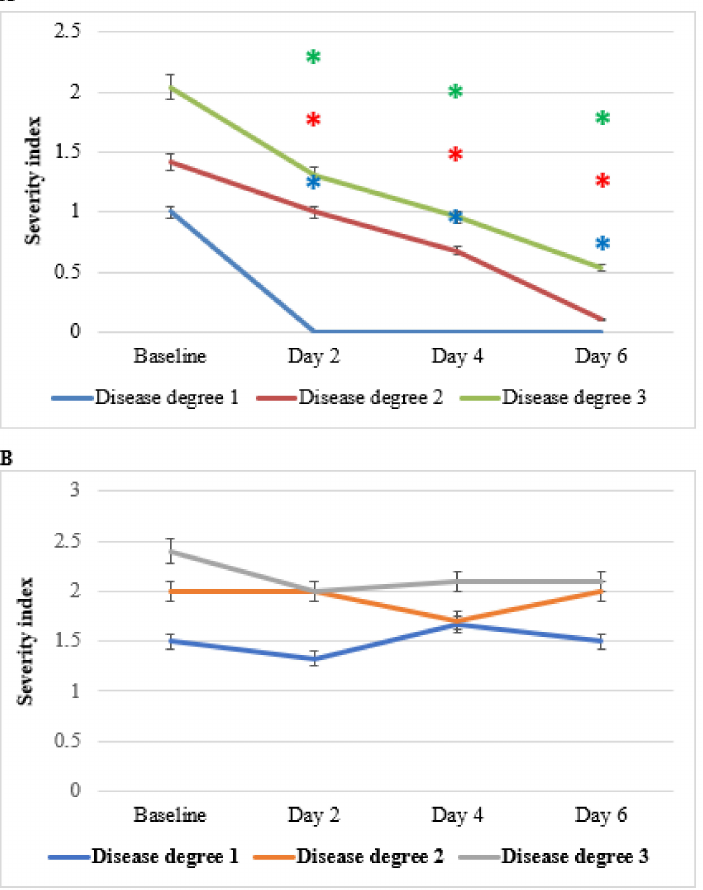
Figure 9. Effect of anti-hemorrhoidal polyherbal cream (HPC) ( A ) placebo ( B ) on hemorrhage severity. Disease Degree 1 (HPC, n = 9; placebo, n = 7), 2 (HPC, n = 7; placebo, n = 7), and 3 (HPC, n = 26; placebo, n = 10). * p < 0.01—significant as compared with